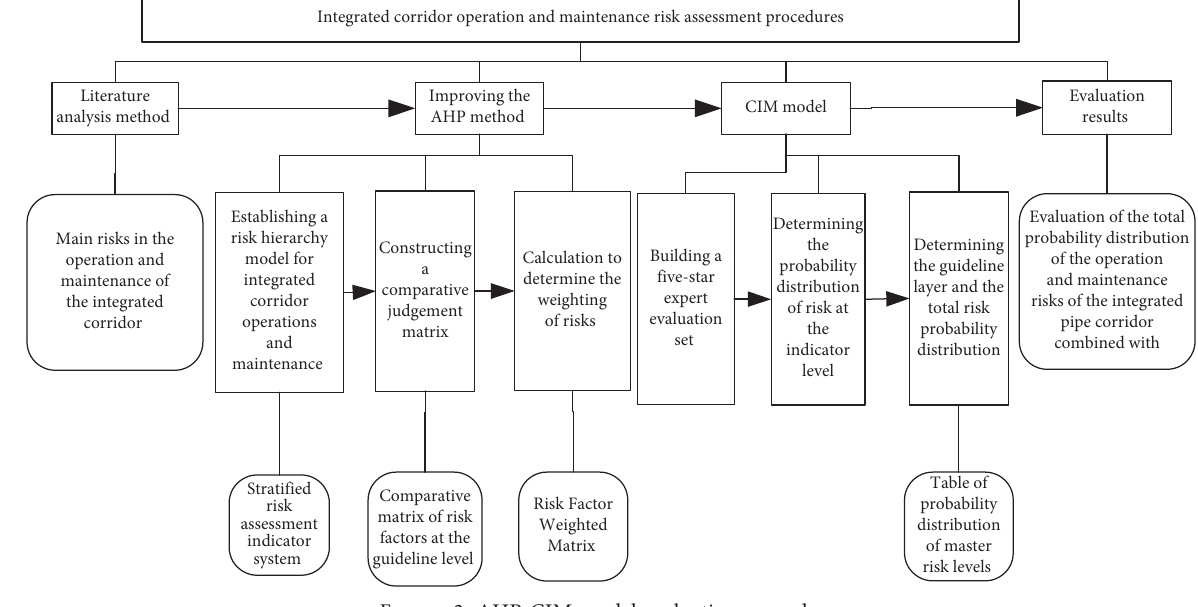
Figure 2: AHP-CIM model evaluation procedure. Table 3: Literature collection on the main risk factors of the integrated corridor O&M management